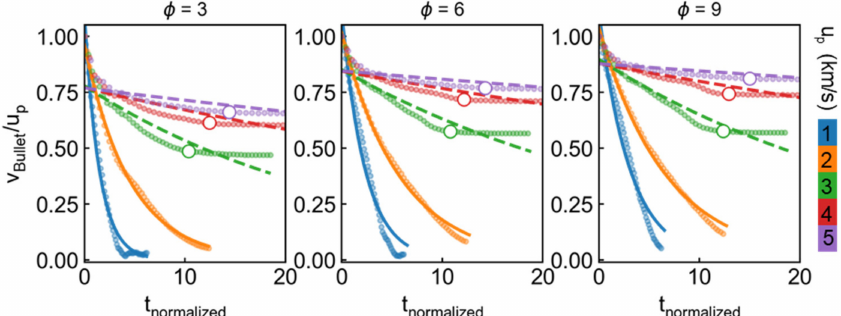
Figure 4. History of bullet velocity v bullet with time under different u p and ∅ . Both axes are normalized to simplify analysis. X-axis is normalized by the form of: t normalized = t × u p /t t , where t t indicates thickness of target and is equal to 8.1 nm. The solid points are original data and hollow points represent the inflection points of curve. The solid line and dash line are the fitted data by the form of: y = ae bx , where a and b are two fitted parameters.